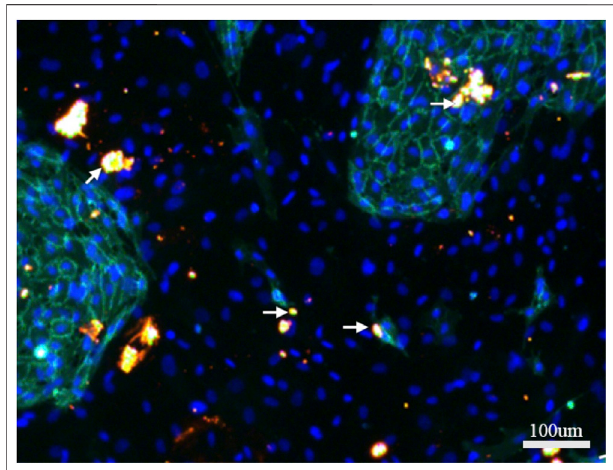
FIGURE 4 | Immuno fl uorescence staining of CX43 between hBMSCs and HUVECs in direct co-culture. CX43 (orange) to label the linker protein, CD31 (green) to label HUVECS, DAPI (blue) to show nuclei.White arrows indicate the CX43 expression between hBMSCs and HUVECs.